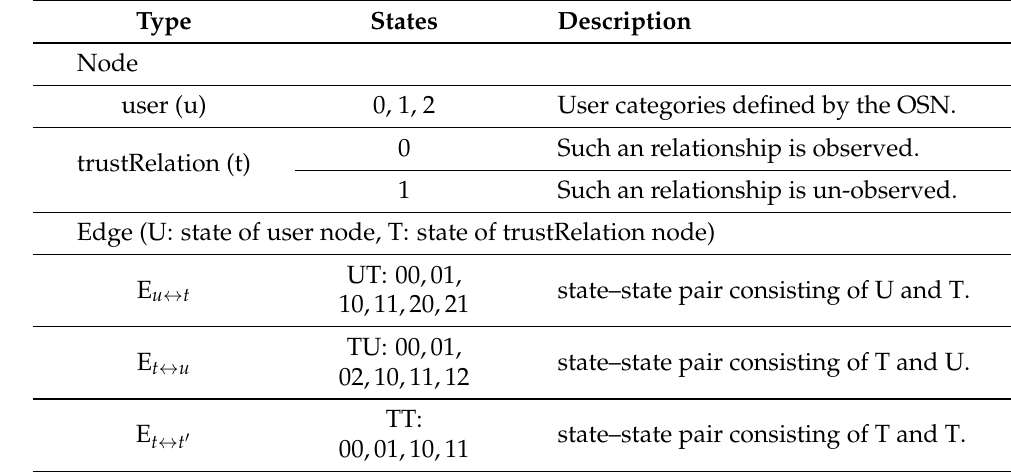
Table 6. Configurations of node state and edge state–state